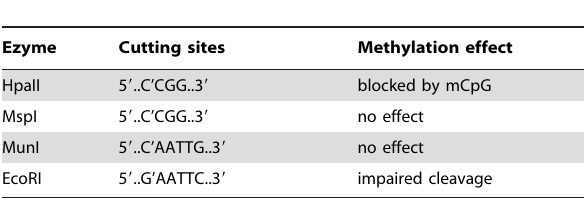
Table 3. Overview of cutting sites for restriction